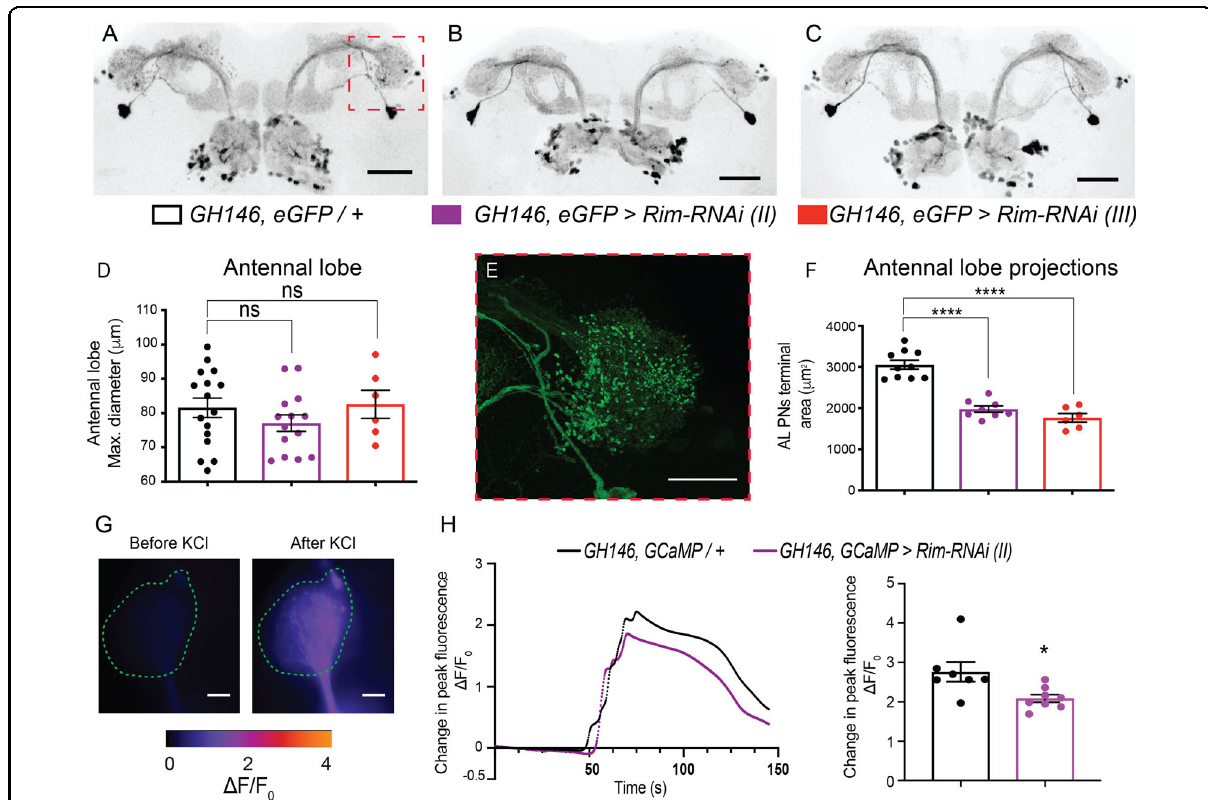
Fig. 2 Rim knockdown altered the structure and function of antennal lobe projection neuron (AL PN) terminals on to the lateral horn (LH). Representative images of GFP expression in the antennal lobe projection neurons (AL PNs) of A control ( GH146, eGFP / + ); B GH146, eGFP>Rim-RNAi (II) ; and C GH146, eGFP>Rim-RNAi (III) showed no apparent gross morphological difference. Scale bars represent 50 μ m. D Knocking-down Rim in the projection neurons did not affect the antennal lobe structure as maximum diameter remained unchanged when compared to control fl ies. E A representative confocal image of the terminals reaching the lateral horn from AL PNs labelled by GH146, eGFP (from red square in A ). Scale bar represents 20 μ m. F AL PNs Rim knockdown caused a reduction in the area covered by these terminals to about half that of controls. Data were analysed with one-way ANOVA followed by a Dunnett ’ s post hoc test. n ( GH146, eGFP / + ) = 16, n ( GH146, eGFP>Rim-RNAi (II) ) = 14 and n ( GH146, eGFP>Rim-RNAi (III) ) = 6 brains. G Basal fl uorescence in AL PN terminals on to LH was low under basal conditions (left panel) while exposure to a depolarizing, high concentration of potassium chloride (KCl) causes an increase in fl uorescence (right panel). Calibration bar showing the changes in fl uorescence can be observed below. Scale bars show 10 μ m. H high [KCl]-induced calcium transients were observed in control fl ies and a reduced response was detected in Rim knockdown fl ies; both responses eventually returned to baseline after high [KCl] was washed out (mean fl uorescence as solid lines). A reduction in the amplitude of the peak fl uorescence was found upon Rim knockdown (Mann – Whitney test). n ( GH146; GCaMP / + ) = 7 and n ( GH146; GCaMP>Rim-RNAi (II) ) = 8